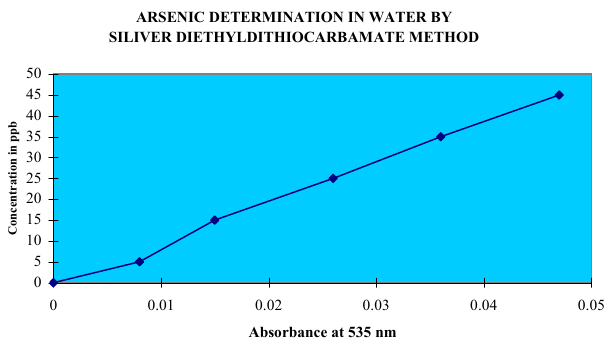
ARSENIC DETERMINATION IN WATER BY SILIVER DIETHYLDITHIOCARBAMATE METHOD